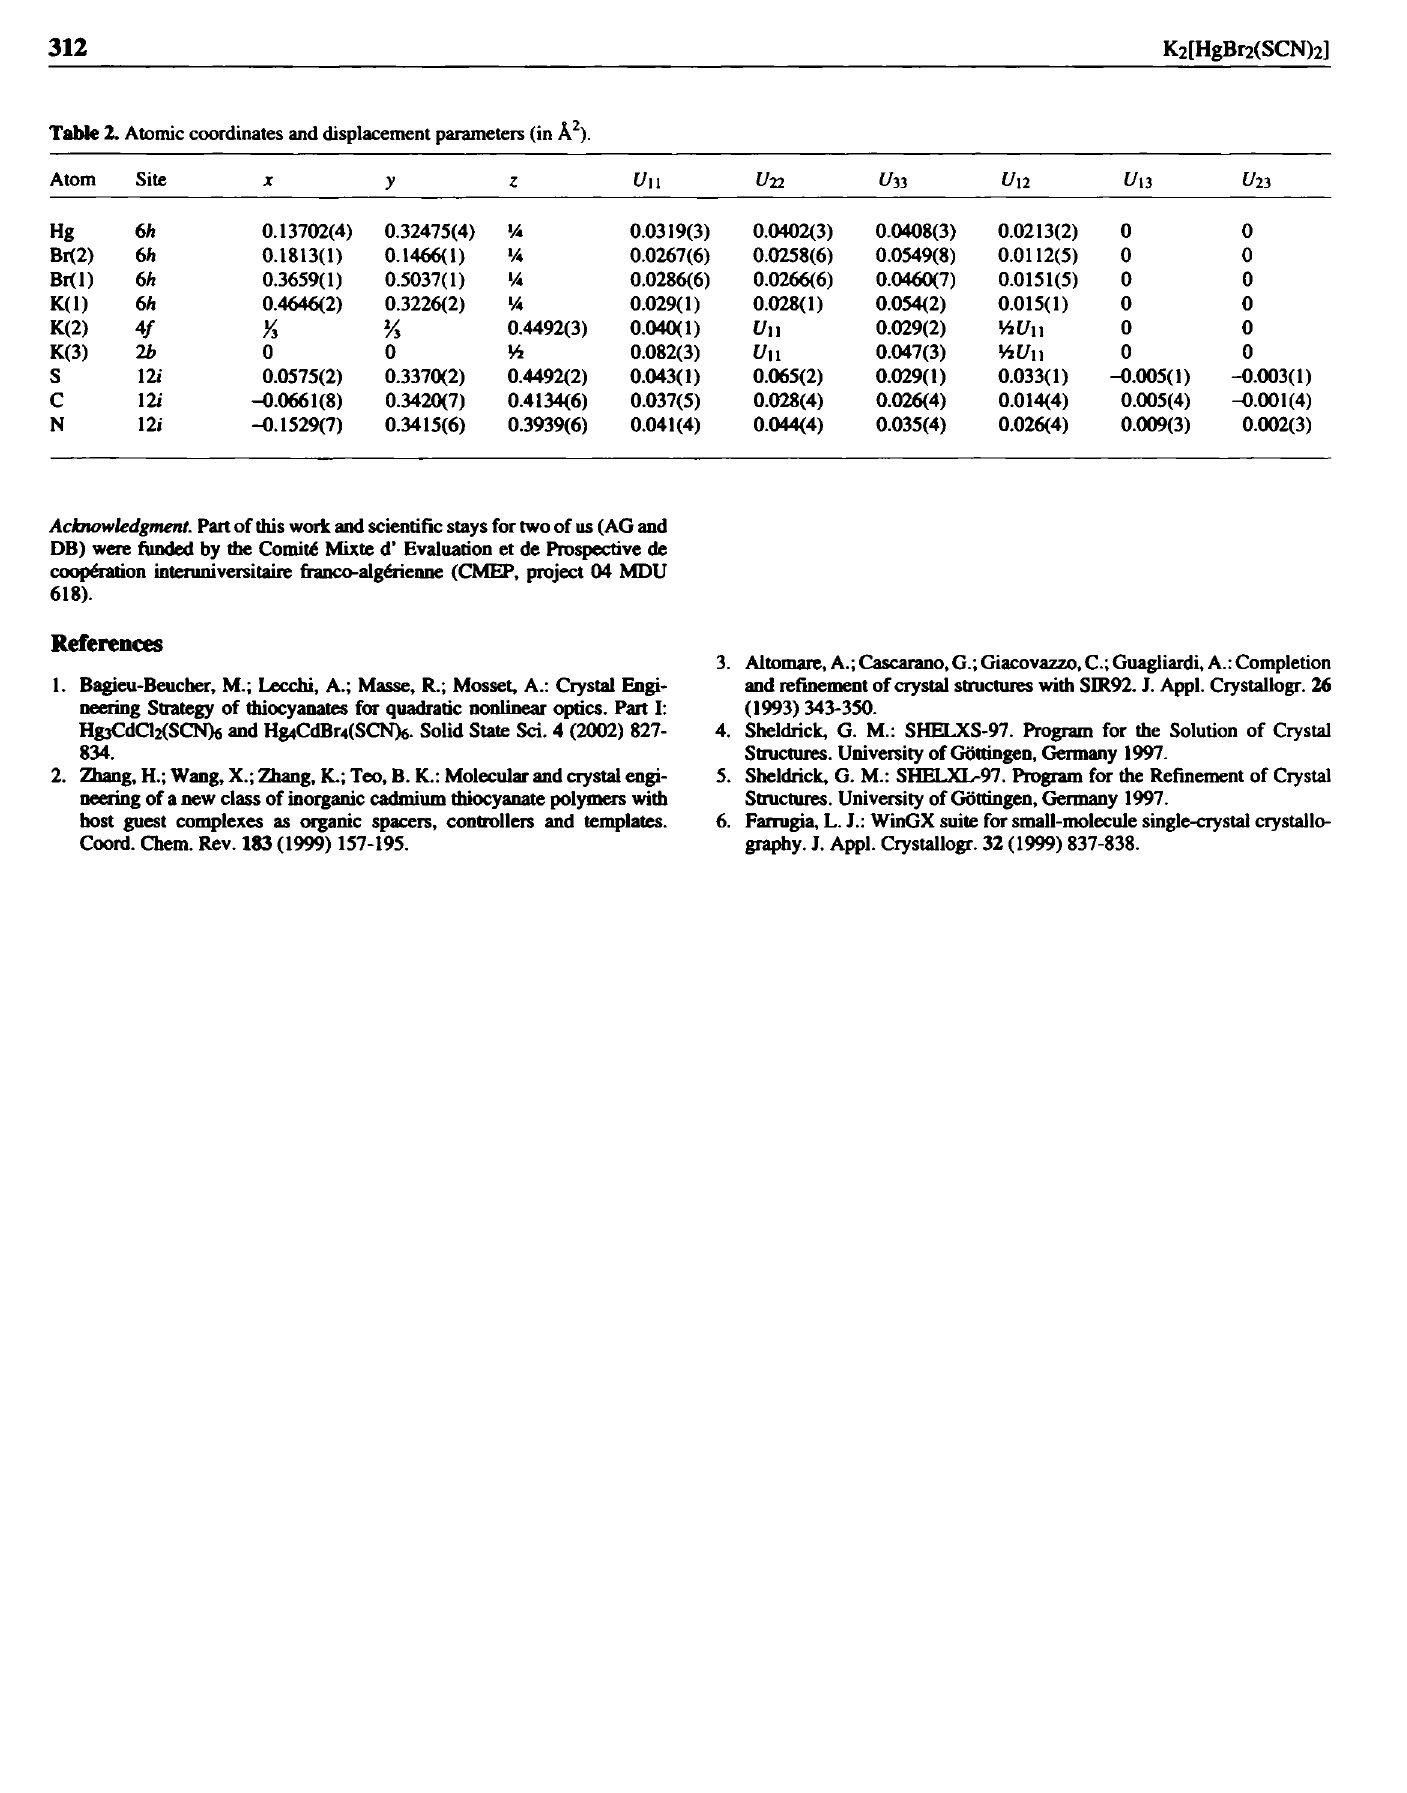
Table 2. Atomic coordinates and displacement parameters (in Ä 2